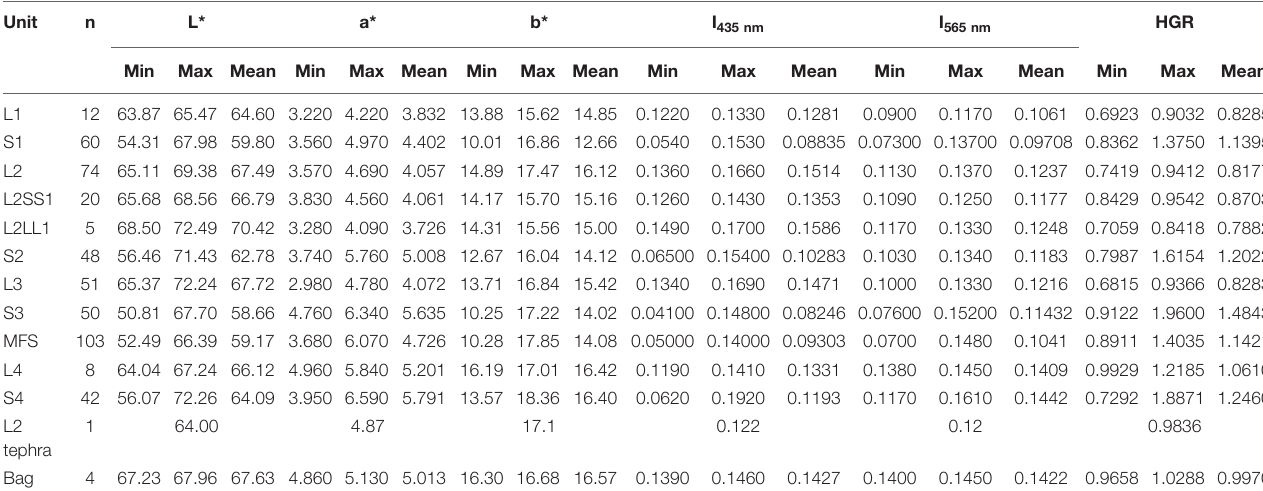
FIGURE 7 | IRM acquisition coercivity distribution and unmixing of coercivity spectra. Values are given in log scale. (A,F) compare IRM acquisition curves for samples measured for FORCs. (B,G) are comparisons of the first derivatives of the IRM acquisitions. (C–E) and (H–J) display the different results of the unmixing. TABLE 4 | Summary of colorimetric parameters. HGR is the calculated hematite/goethite